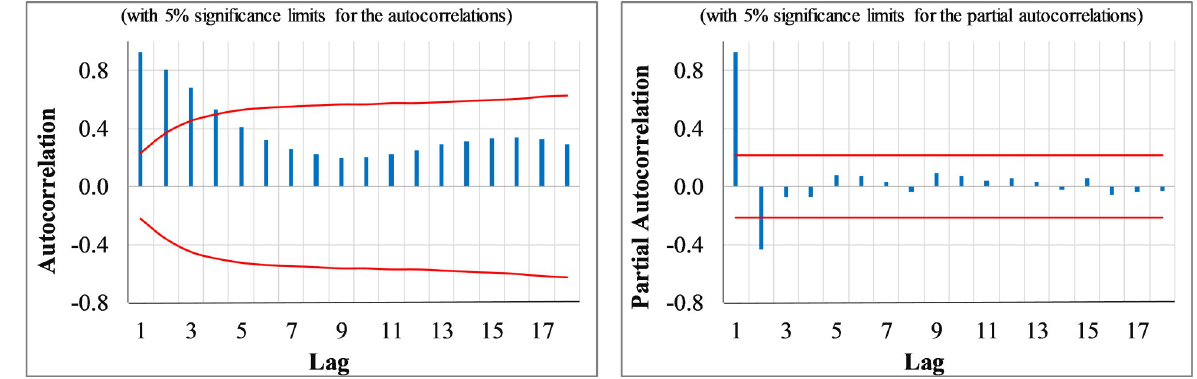
Fig 6. The ACF and PACF plots of the original weekly new confirmed COVID cases time